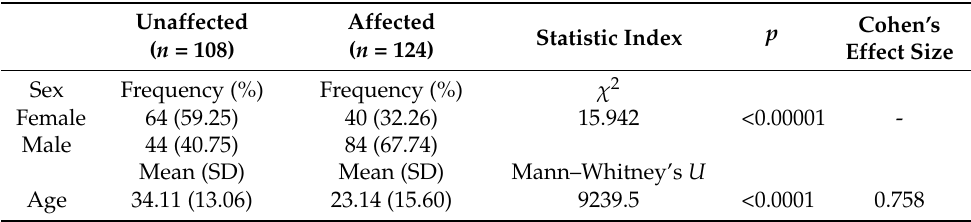
Table 1. Demographic characteristics of 232 individuals included in this study.